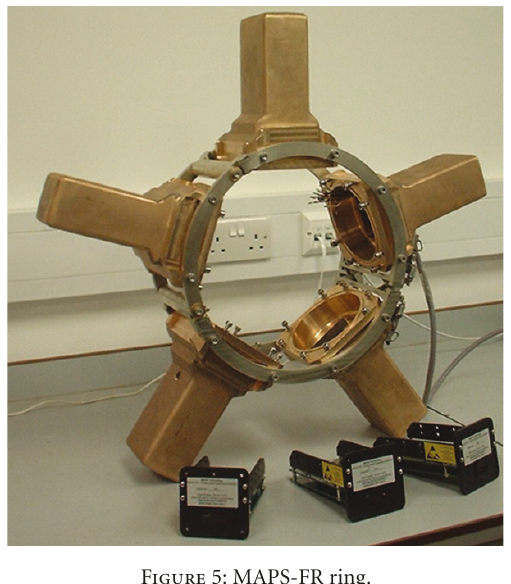
Figure 5: MAPS-FR ring.